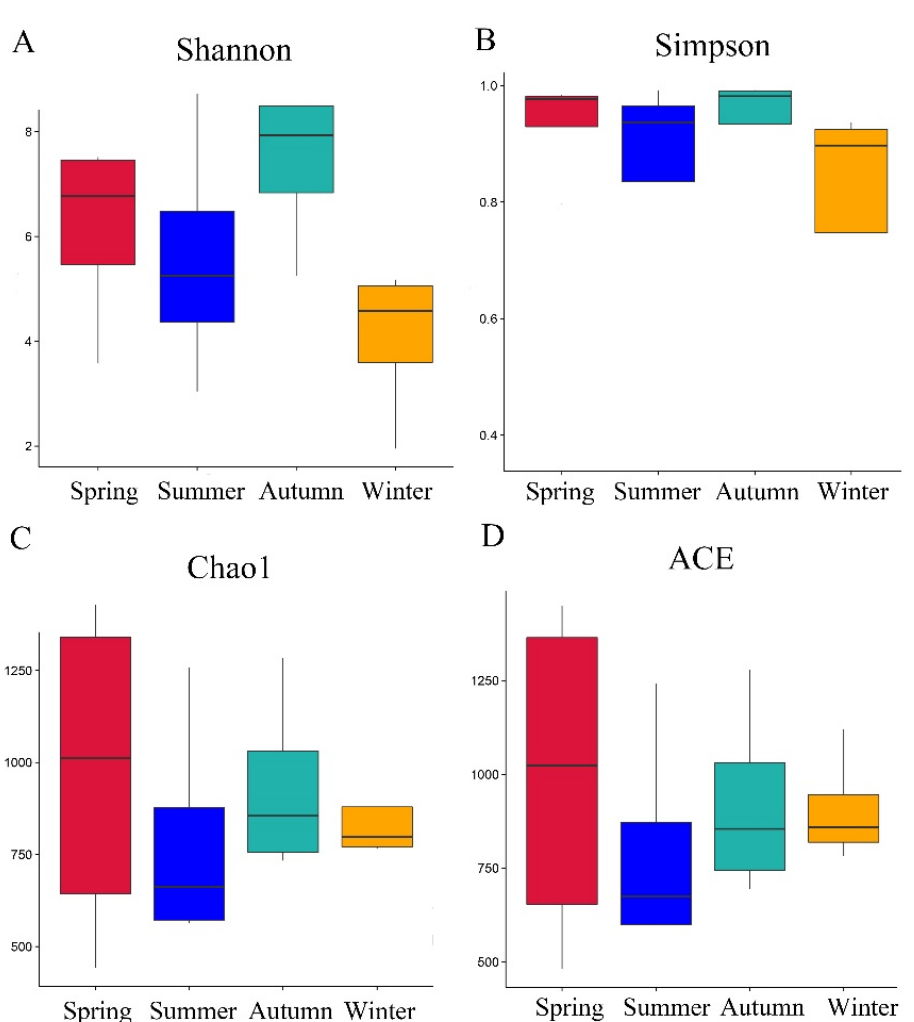
Figure 1. Diversity and community richness indices in four different seasonal groups. ( A ) comparison of Chao1 diversity indices in four different seasonal samples. ( B ) comparison of Shannon diversity indices in four different seasonal samples. ( C ) abundance measurement index calculated by the Simpson method. ( D ) abundance measurement index was shown by the ACE.